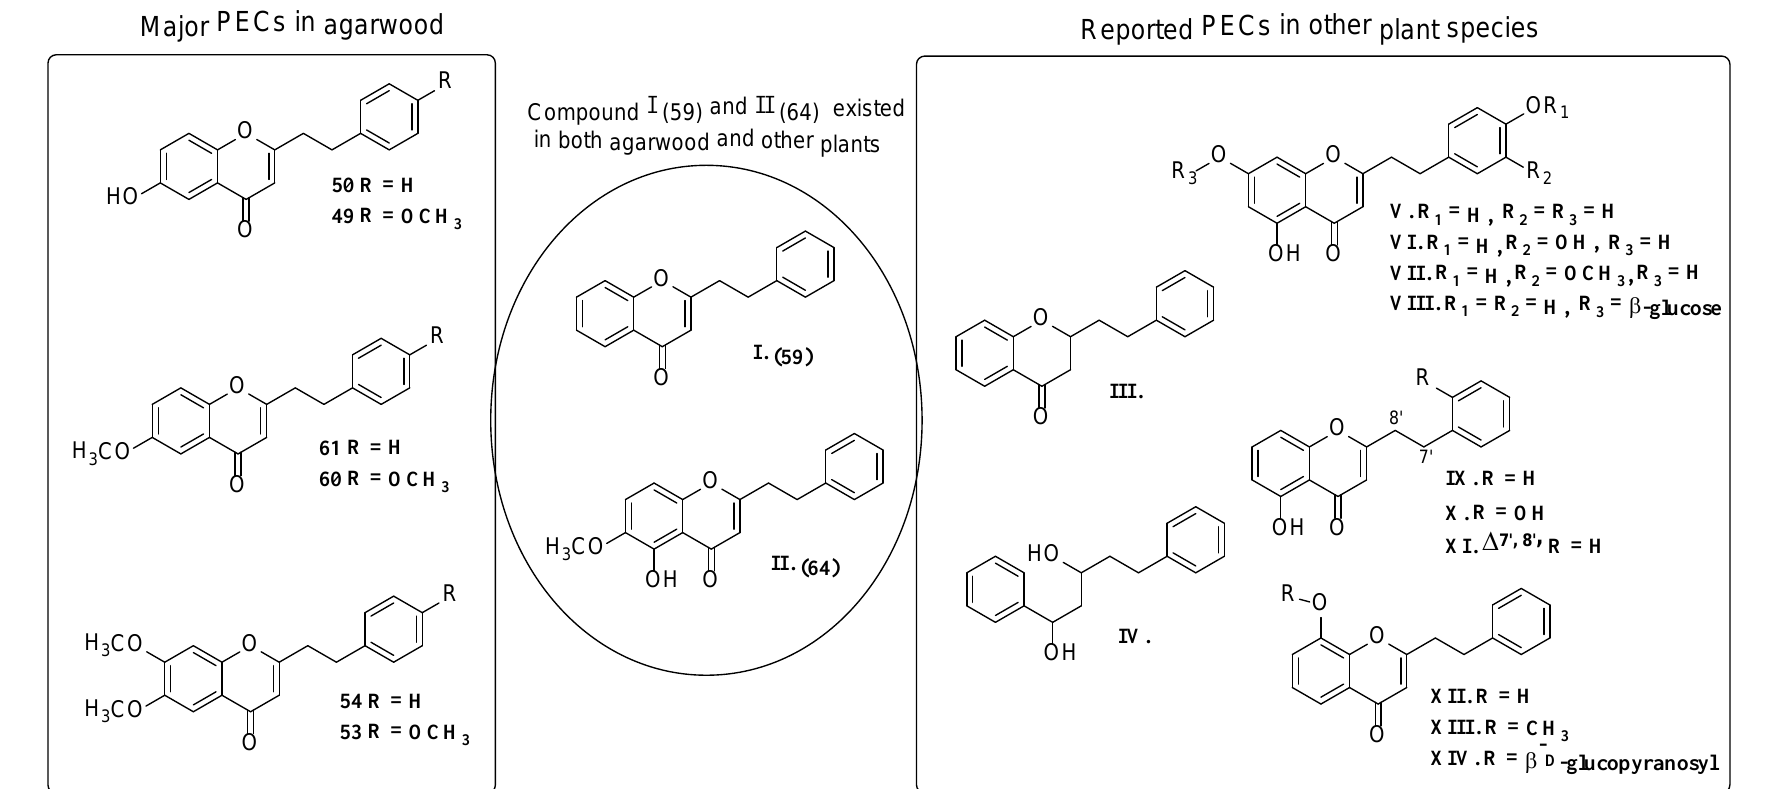
Figure 3. Comparison of major PECs derived from agarwood and other plant species.